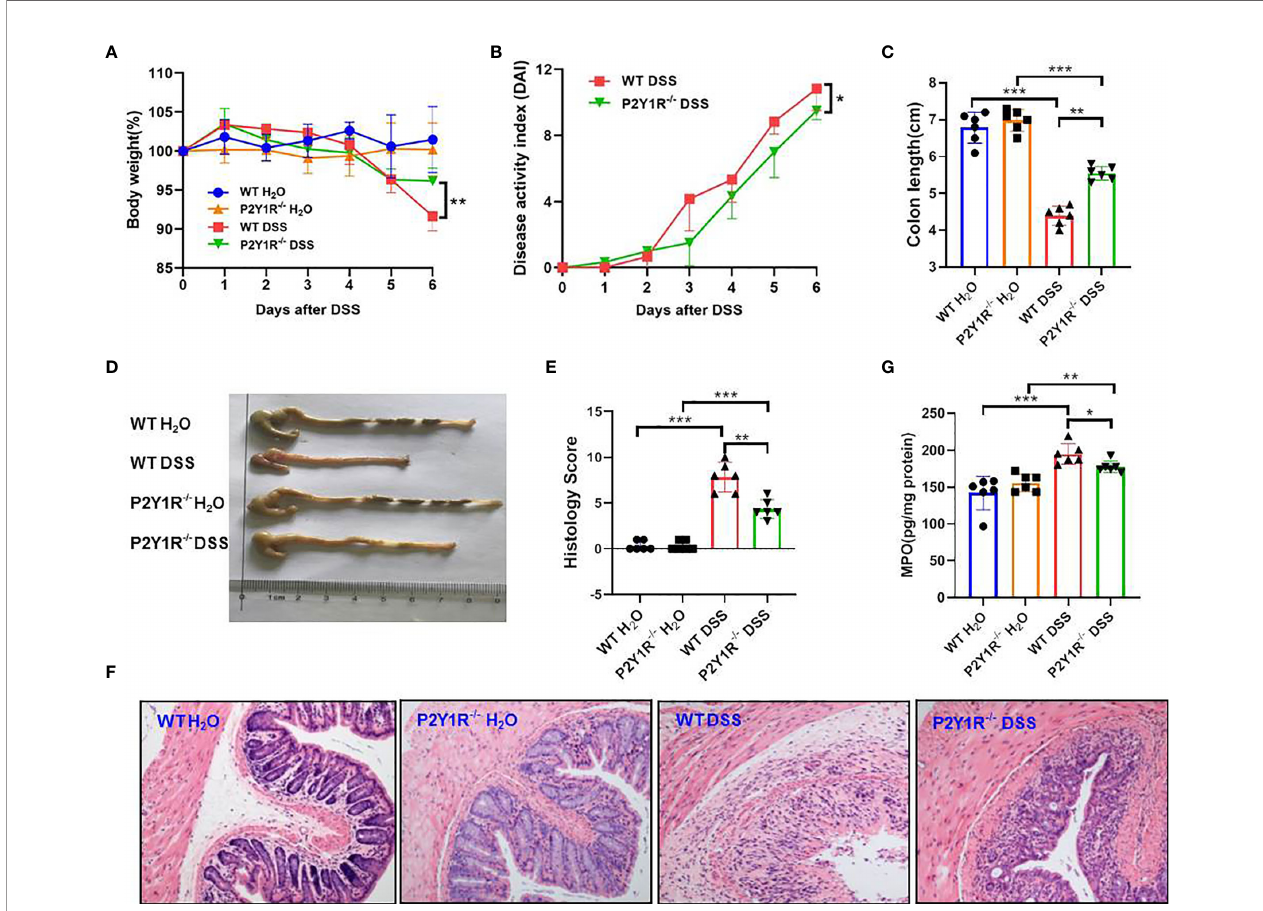
FIGURE 2 | P2Y1R de fi ciency ameliorates DSS-induced colitis in mice. (A) Body weight change. (B) Disease activity index (DAI). (C) Colon length. (D) Representative photographs of colon. (E) Histopathological score of colon tissues. (F) Representative photographs of H&E staining (magni fi cation × 200). (G) Myeloperoxidase (MPO) level. Data are expressed as mean ± SEM (n=6). *p < 0.05, **p < 0.01 and ***p <